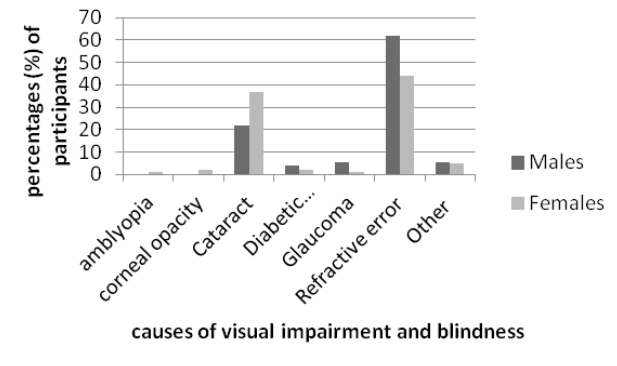
Figure 1: The causes of visual impairment and blindness in the right eyes of males and females.